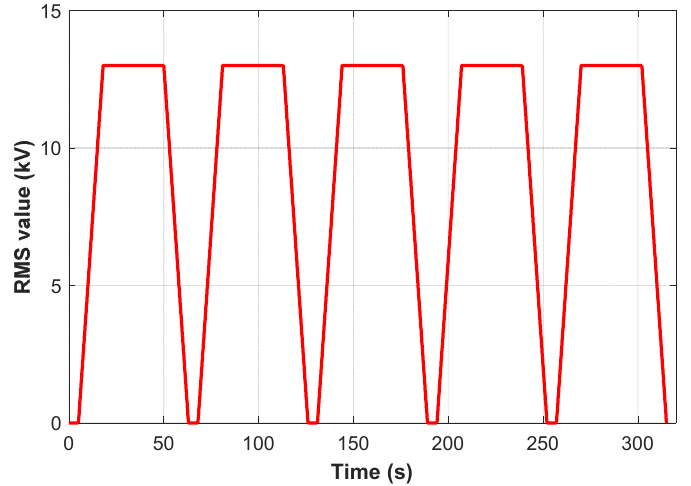
Figure 3. Voltage profile (RMS value) applied to samples during partial discharge test. For the comparison and quantification of PD activity, we are interested in the PD inception voltage (PDIV), PD extinction voltage (PDEV) during raise and falling times, respectively, and average charge (Q avg ), peak charge (Q peak ), and number of PDs (NPDs/s) during the voltage plateau (at 13 kV RMS). It is about the average charge and the number of PDs per second (NPD/s) during the 32 s, while Q peak is the highest charge recorded in the same interval. In addition, the phase-resolved PDs pattern is also compared and plotted for the four